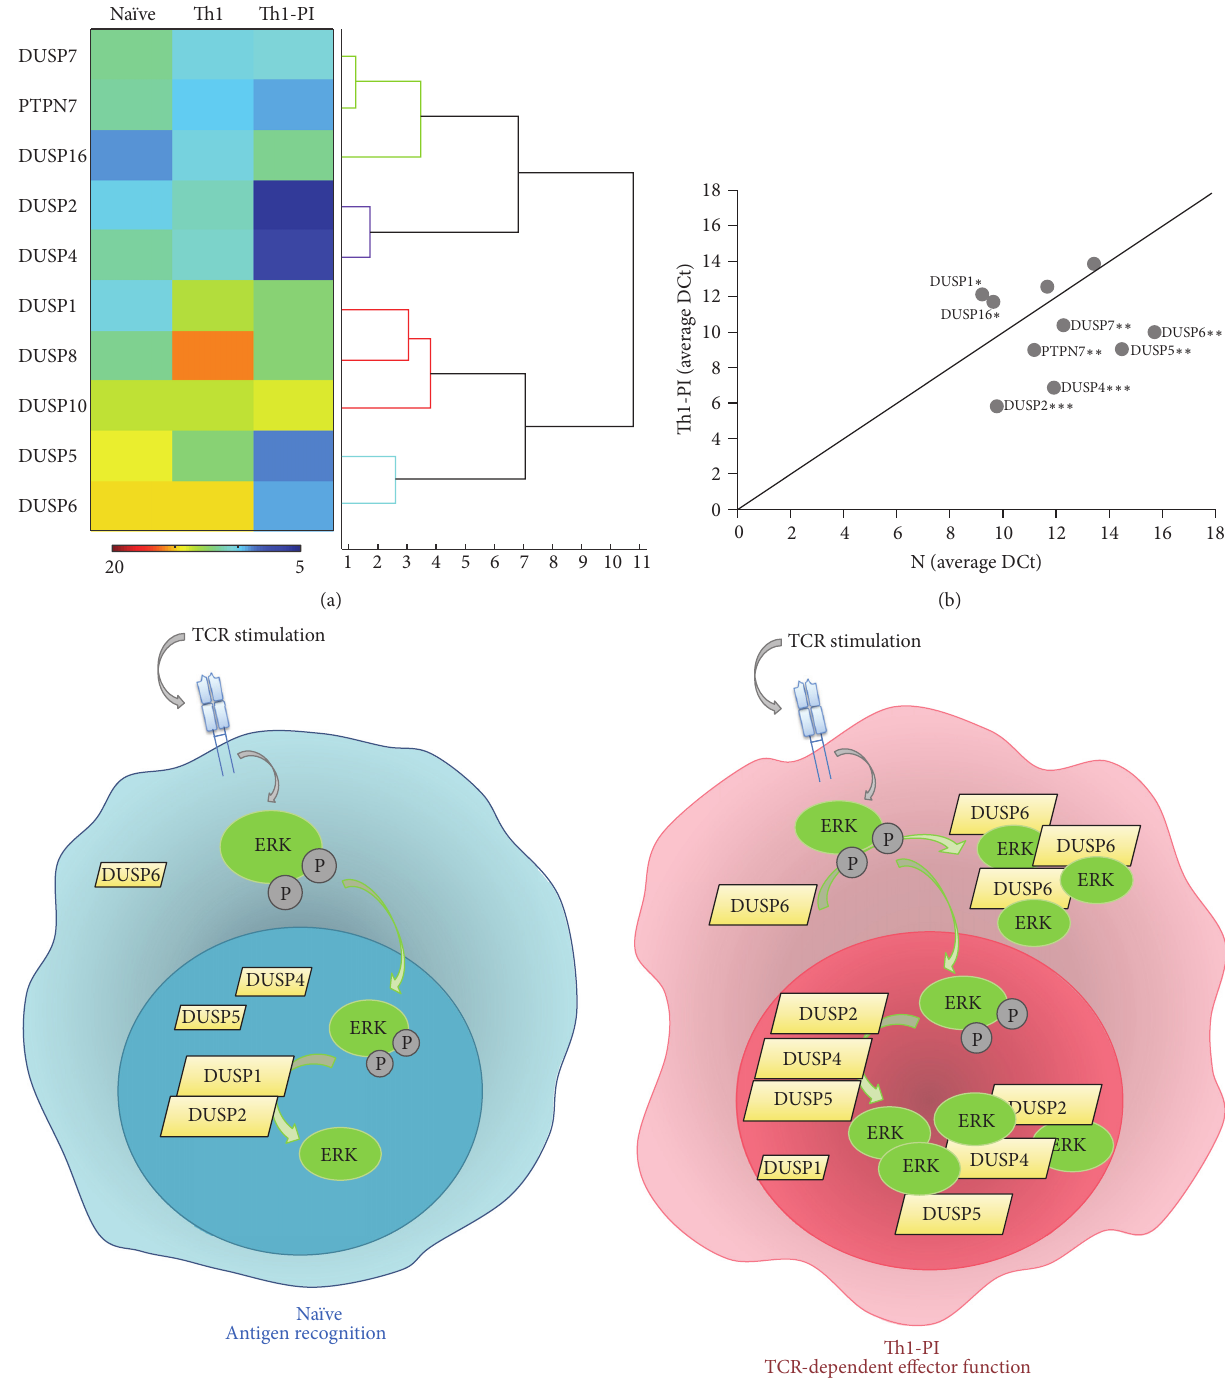
Figure 4: Expression of regulators of the MAPK signalling module in na¨ıve and Th1 cells. (a) Agglomerative hierarchical tree of the expression profile of MAPKs phosphatases in na¨ıve, Th1, and Th1-PI samples. Numbers under the tree indicate the distance among the expression profile. Hitmap represents the average DCT obtained for each gene in all samples and 2 donors. Calibration bar is shown between 5 and 20 DCTs. (b) The average DCT obtained for classical MPKs and PTPN7 in na¨ıve (N) and PI treated Th1 cells (Th1-PI) is plotted. The diagonal line labels the position of genes with equal expression levels in both samples. Labelled genes are those with different expression level assessed as explained in material and methods. ∗∗∗ 𝑝 < 0.001 , ∗∗ 𝑝 < 0.01 , and ∗ 𝑝 < 0.05 correspond to the probability of paired 𝑡 -test used in comparisons of the DCT values obtained for each gene in na¨ıve and Th1-PI samples from 4 donors. (c) Schematic of proposed spatial regulation of ERK during CD4 T cell immune responses. Dominance of partners of the dephosphorylated ERK in cytoplasm or nucleus might mediate the accumulation of this MAPK and, consequently, promote ERK functions nonmediated by the kinase activity in restimulated Th1